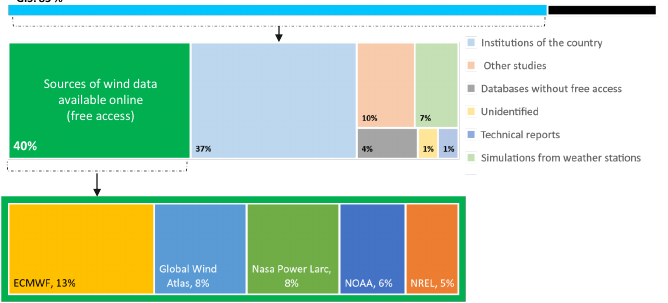
Figure 10. Results of identification by contributions. GIS integration. Own